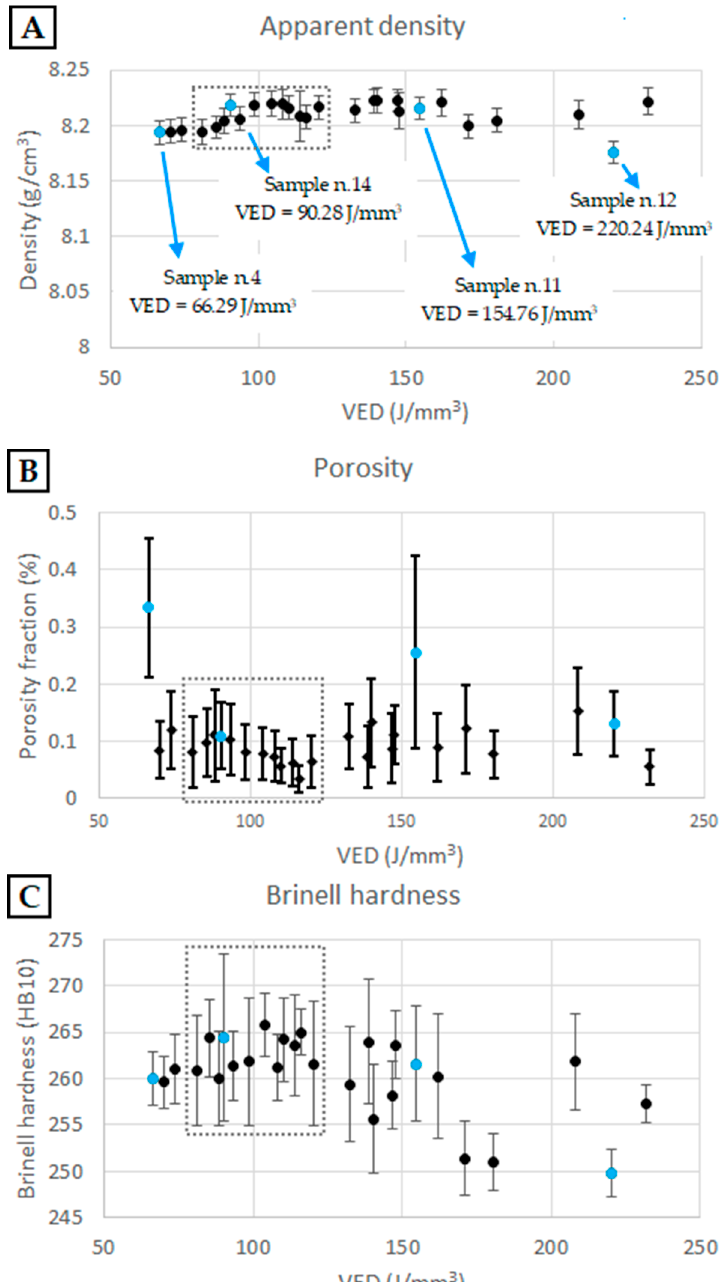
Figure 2. Apparent density ( A ), measured with the Archimedes method; porosity fraction ( B ), evaluated through optical images analysis; and Brinell hardness ( C ) of the selective laser melting (SLM) Inconel 718 samples, produced with different combinations of process parameters as functions of the volumetric energy density (VED) value. In each plot, the blue data points indicate samples n.4, n.14, n.11, and n.12; polished cross sections of which are shown in Figure 3 as examples. The error bars in plots A and C indicate 95% confidence intervals, while the bars in plot B indicate the ranges between the lower and higher estimates of the pore coverage ratio. Adapted from [46].